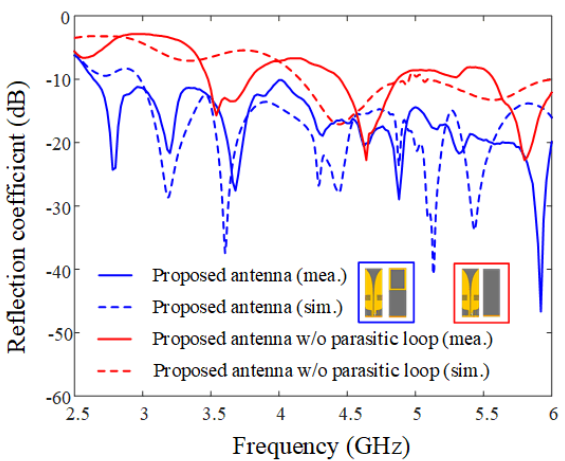
Figure 4. Simulated and measured reflection coefficients of the proposed antenna.